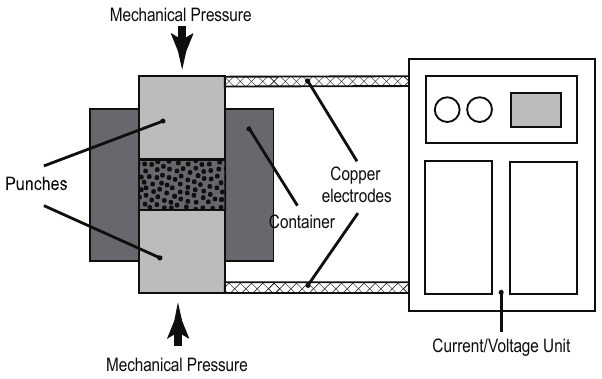
Figure 2: Schematic representation of ECAS